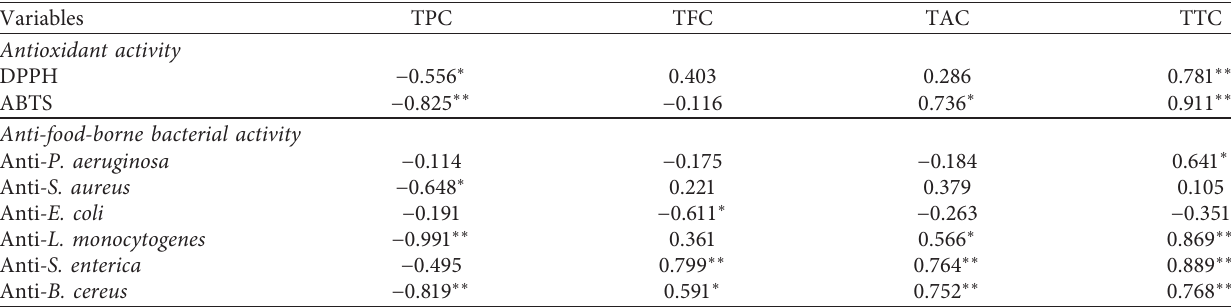
Table 6: Pearson correlation coefficient analysis of phytochemical contents with the antioxidant and anti-bacterial activities of pistachio hull